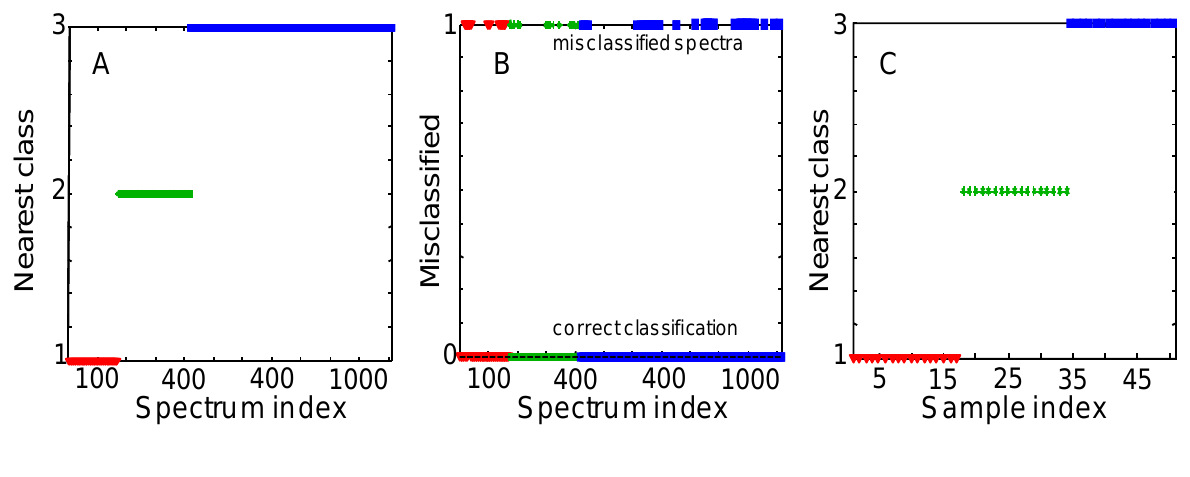
Figure 2. Nearest classes to SIMCA submodels for body fluid samples. Classification of single Raman spectra: correctly classified ( A ) and misclassified ( B ) single Raman spectra. ( C ) Classification of average Raman spectra. Defined classes: human blood ( red triangles ) –class 1, human saliva ( green stars )–class 2, human semen ( blue squares )– class